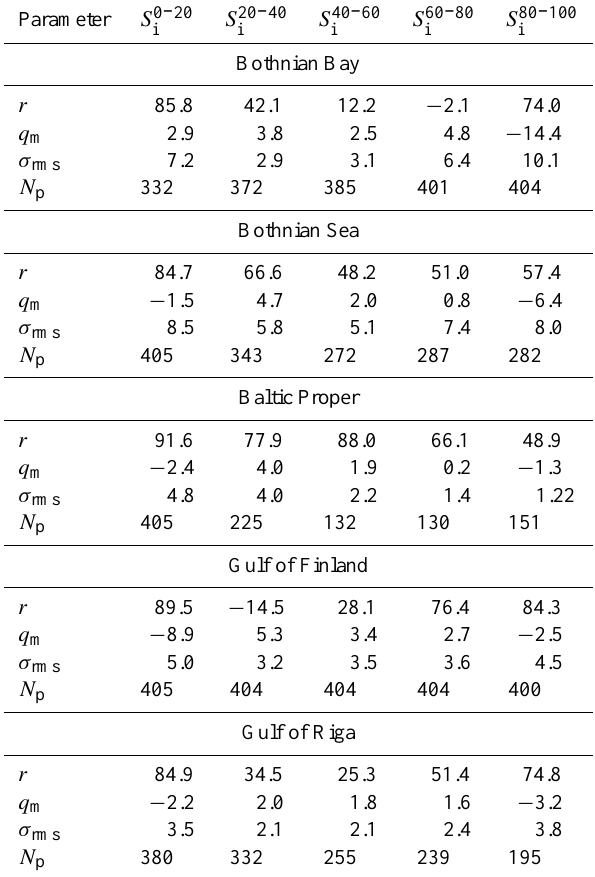
Table 4. Comparative statistics between the satellite-derived and modelled S 0 – 20 , ..., S 80 – 100 in the five basins analyzed. Results i i of the thermodynamic ice model.